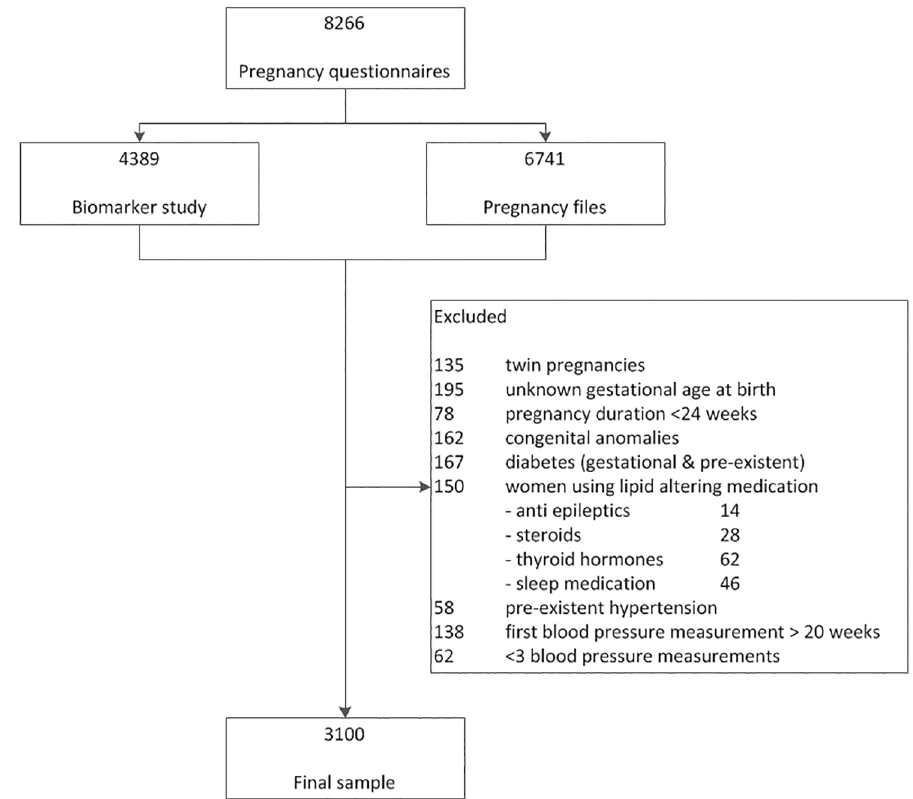
Fig 1. Flowchart of inclusion of the study